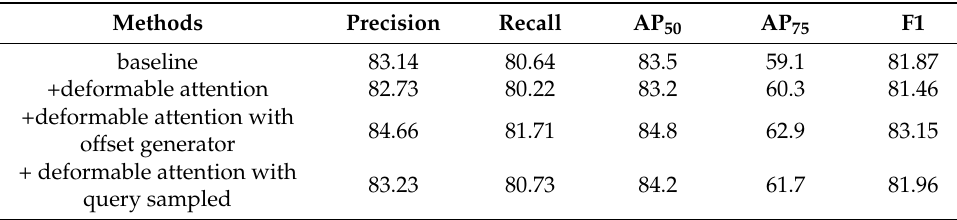
Table 2. Ablation study of the module in the proposed